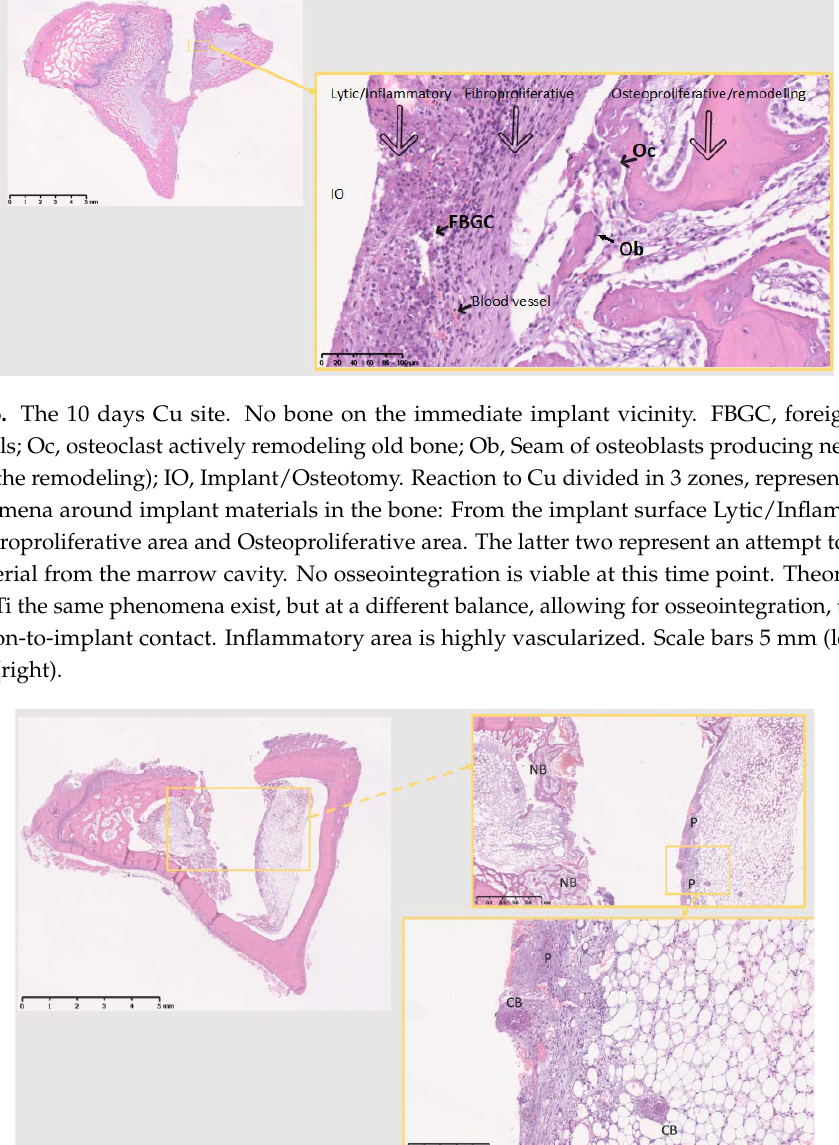
Figure 7. The 10 days PEEK. NB, new bone; forming only in the areas adjacent to cortical bone, while most other interfacial tissue shows no bone formation. P, proliferative area; no visible calcified tissue formation, but for some isolated calcified bone areas (CB, calcified bone). Scale bars, clockwise: 5 mm, 1 mm and 250 µ